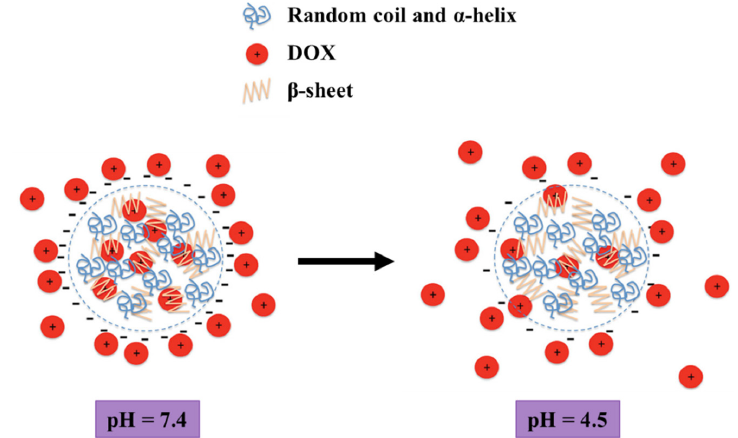
Figure 9. Schematic representation of silk nanoparticles and pH-dependent release of DOX. Diagram not drawn to scale. Reprinted with permission from [58] ; copyright (2013) Wiley Online Library.